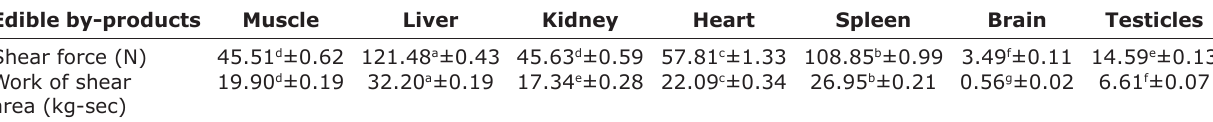
Table-2: Textural characteristics of edible by-products and longissimus dorsi muscle of Barbari kids (means±SE) Edible by-products